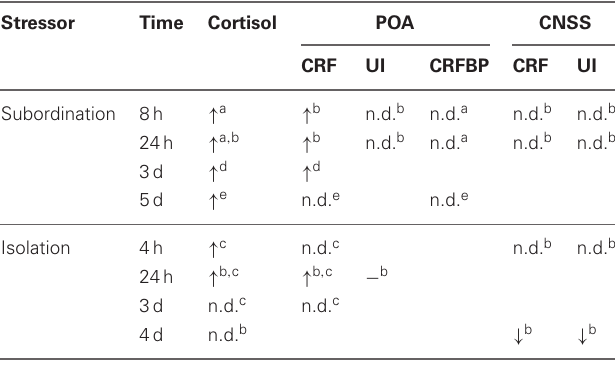
Table 2 | Relative cortisol and mRNA levels of subordinate trout to dominant or control animals (n.d. = no